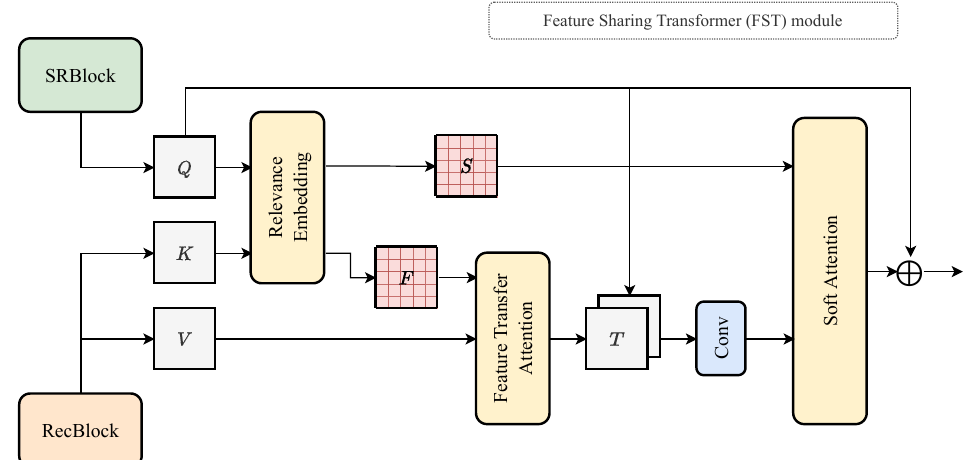
Figure 4. The architecture of the FST module. Feature maps extracted from the reconstruction branch are fused with the feature maps from the SR branch to utilize complementary characteristics, such as noise removal capability and text structure